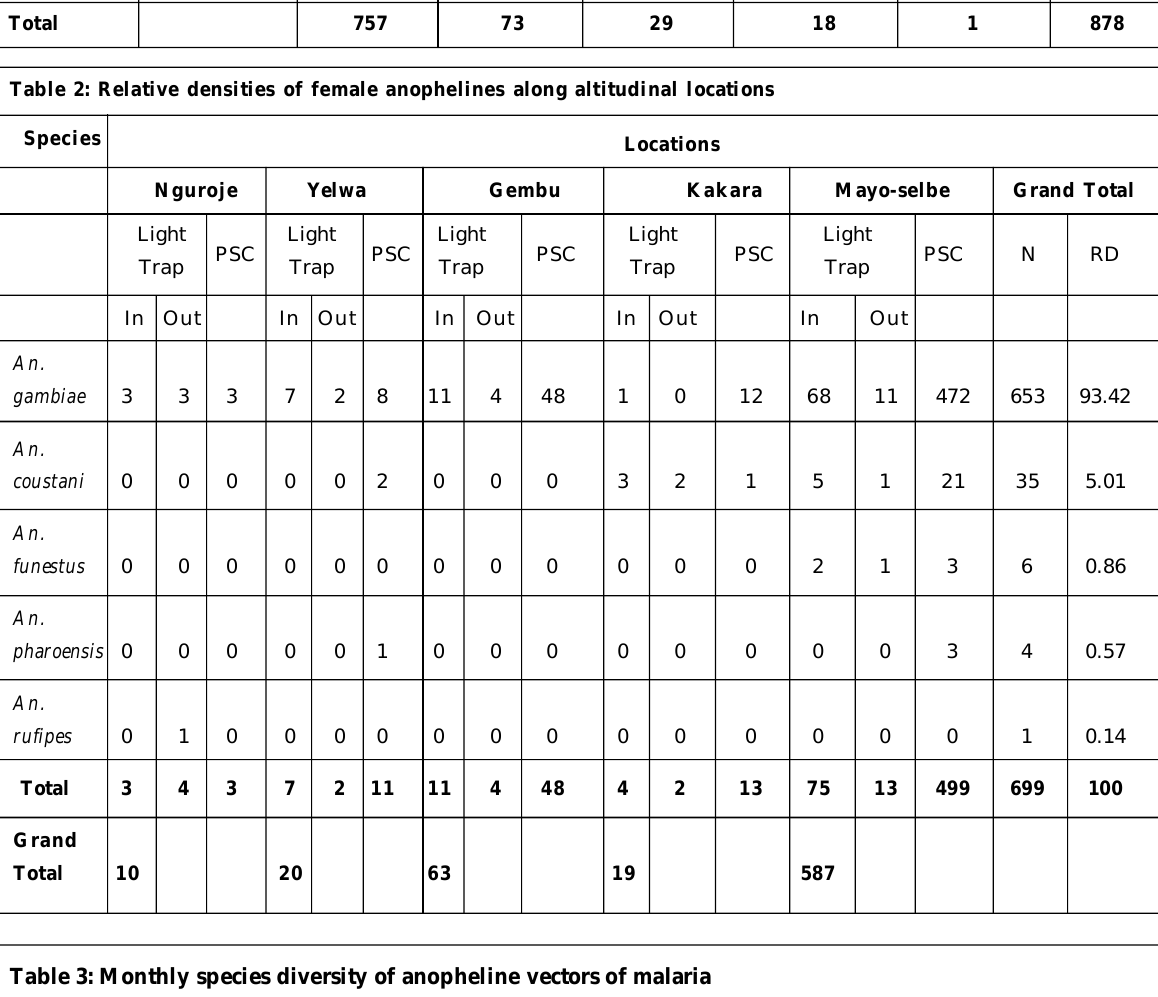
Table 3: Monthly species diversity of anopheline vectors of malaria Species